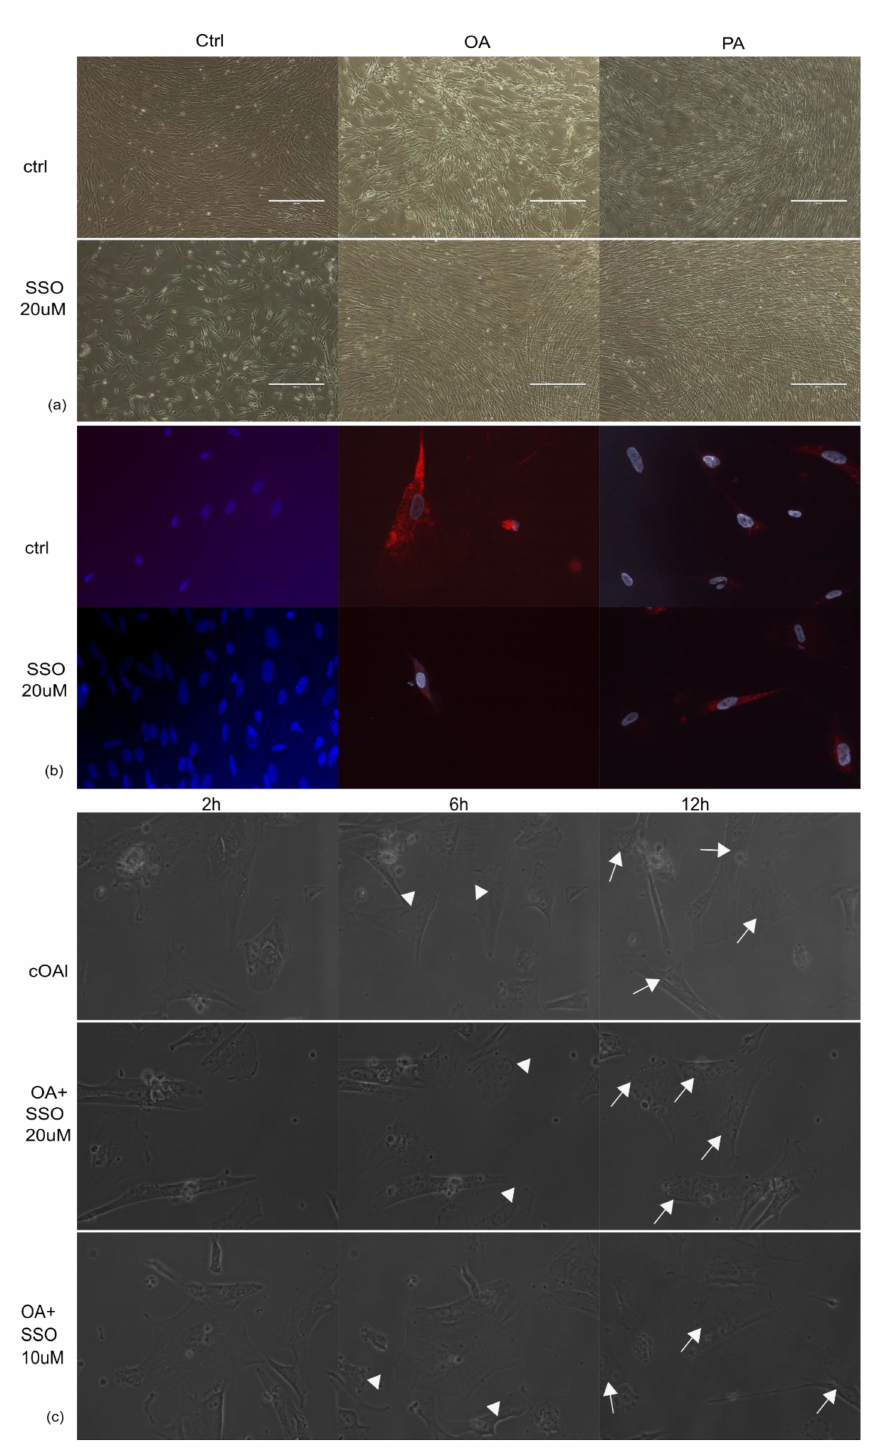
Figure 1. ( a ) Addition of low concentrations of either saturated FA (palmitic acid (20 µ M) or unsat- urated FA (oleic acid, 40 µ M) rescue normal human astrocyte proliferation in cell culture. Phase- contrast, 10 × . Assessment of lipid droplet formation in the presence of SSO pre-treatment by OilRed O stain ( b ) and video microscopy ( c ). SSO treatment does not impede lipid granule formation in the presence of OA, nor the timeline of their accumulation inside cells. In SSO-treated, as well as non-treated cells, granules are visible inside astrocytes as soon as 6 h (arrow heads) and clearly observed at 12 h